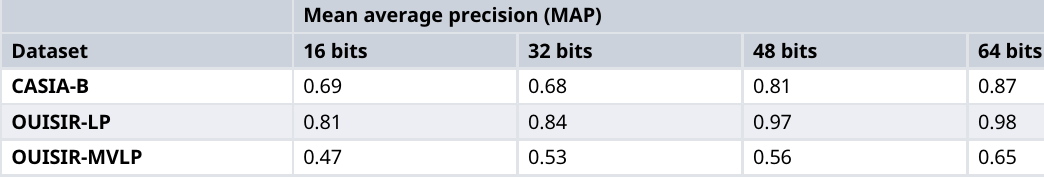
Table 3. MAP for the OUISIR-LP dataset in the same-condition setting.